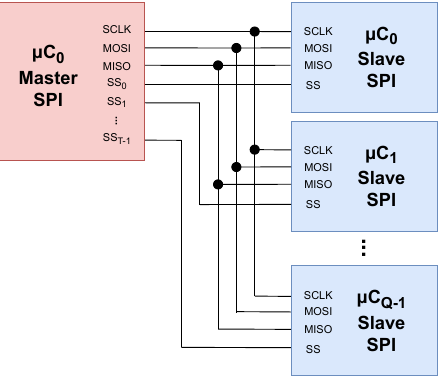
Figure 7. Example of the Serial Peripheral Interface (SPI) wiring